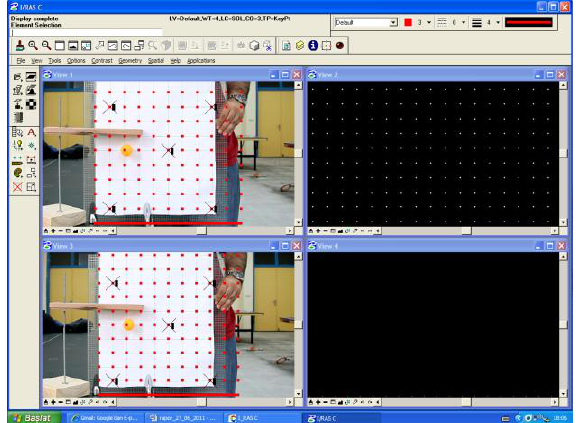
Figure 7. Scaling with projective